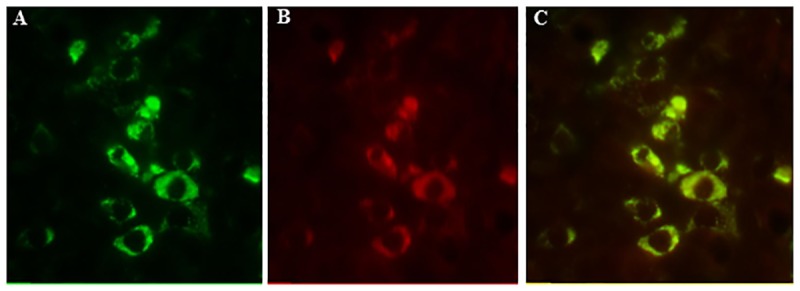
Localization of GH and leptin receptor (OB-Rb) on paraffin embedded pituitary sections using double-labeled immunofluorescence microscopy.GH (green) positive cells (A); OB-Rb (red) positive cells (B); and merged images for GH and OB-Rb expressing cells (C) showing co-localization in somatotropes.